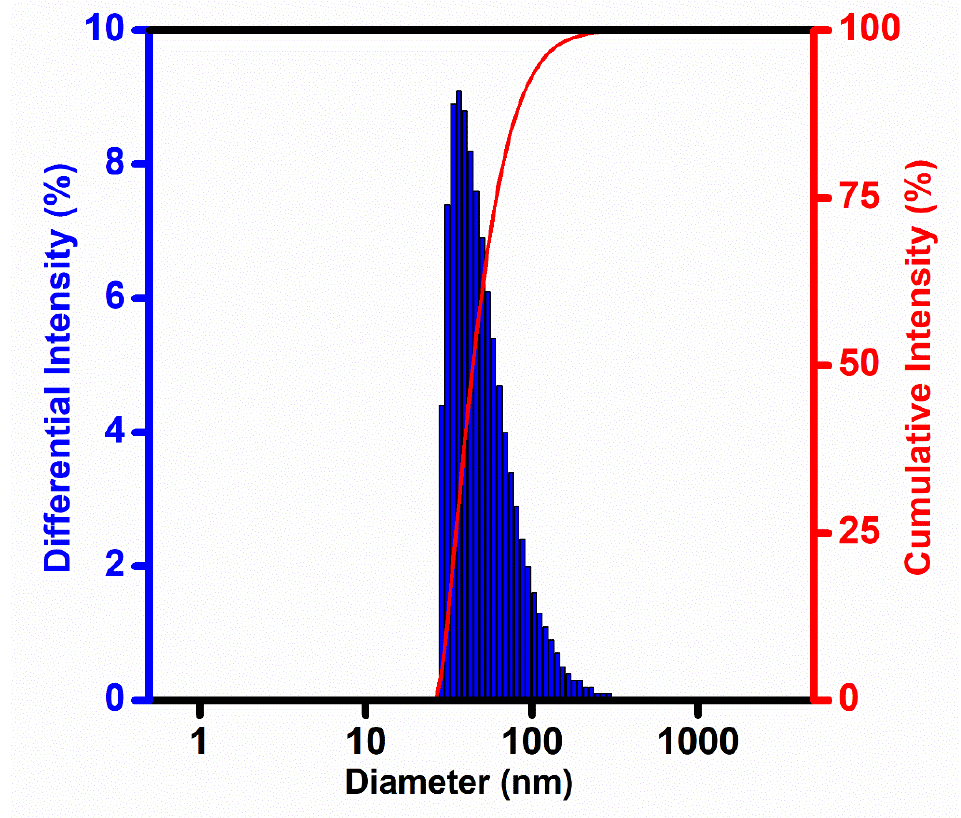
Figure 5. DLS analysis of